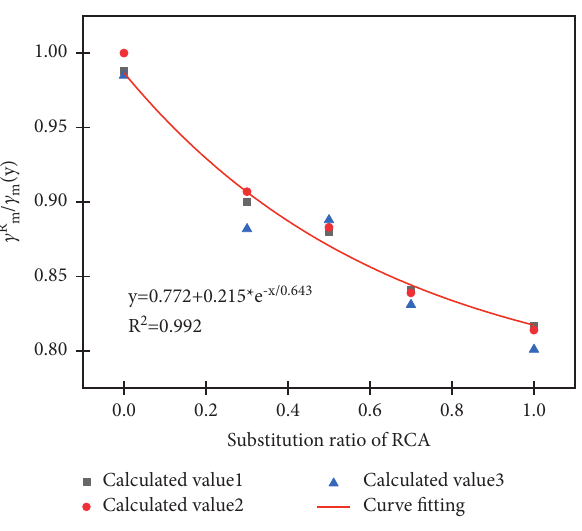
Figure 11: Fitting curve.